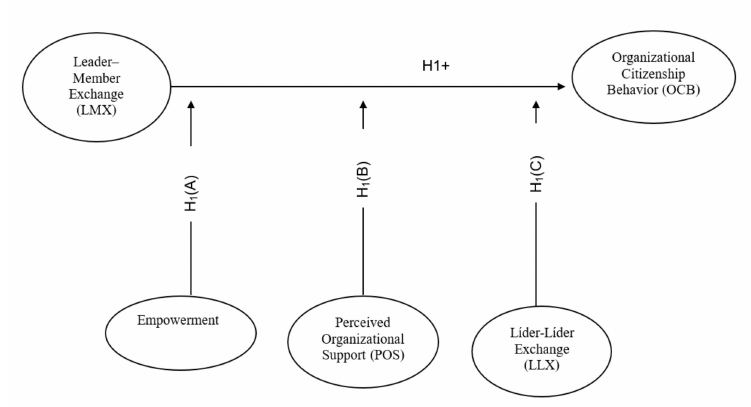
Figure 1. Theoretical model. Figure made by the authors.